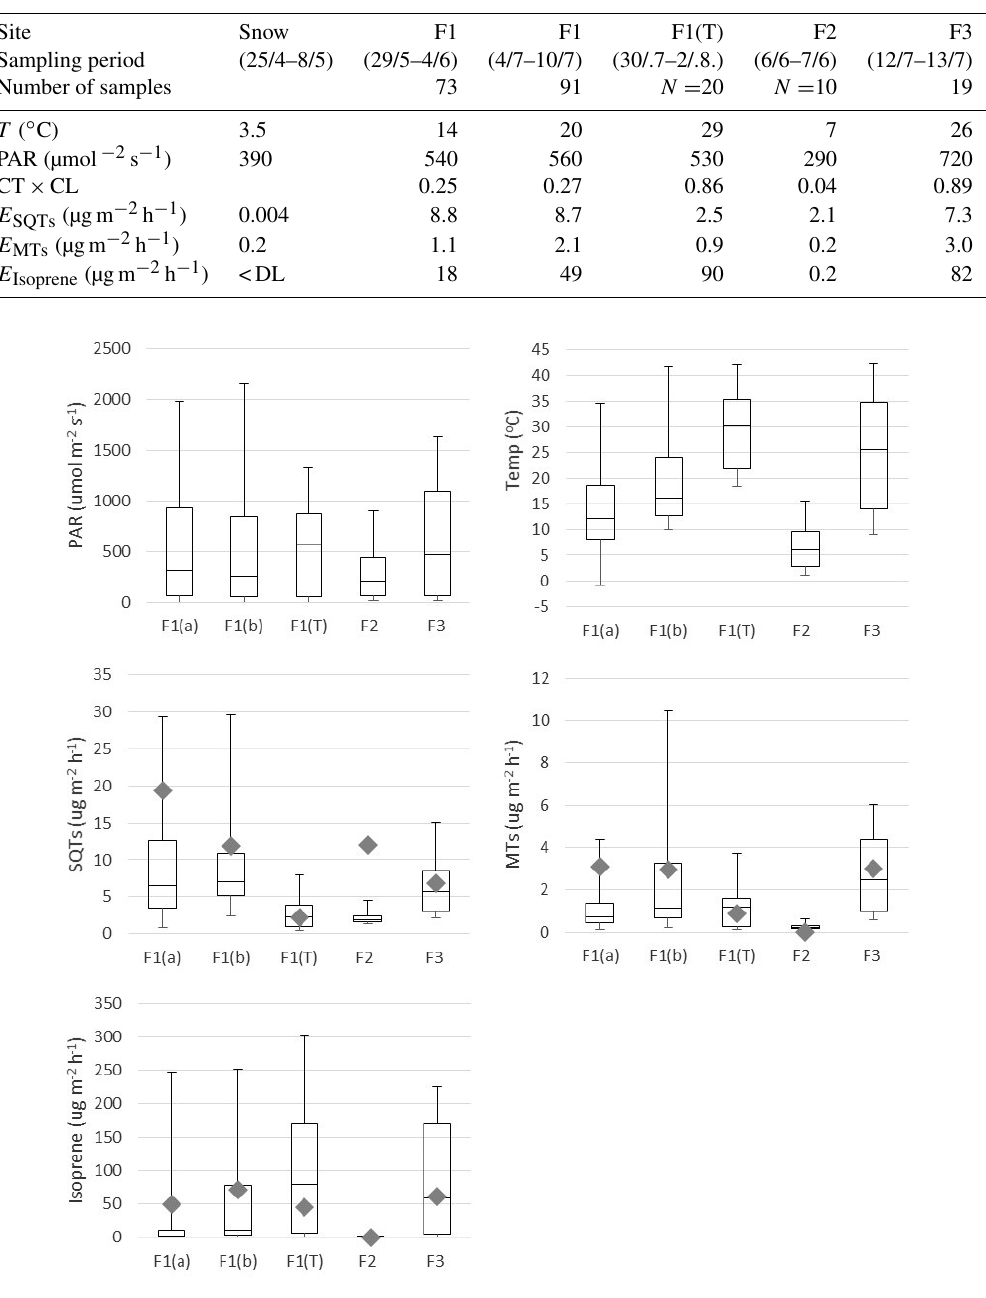
Figure 2. Mean box-and-whisker plots of photosynthetically active radiation (PAR), temperature (Temp), and emission rates of sesquiter- penes (SQTs), monoterpenes (MTs) and isoprene during the various emission measurement periods. The boxes represent first and third quartiles and the horizontal lines in the boxes the median values. The whiskers show the highest and lowest observations. Grey diamonds represent monthly mean emission potentials ( T = 30 ◦ C) and diamonds emission potential ( T = 30 ◦ C and PAR = 1000µmol − 2 s − 1 ). F1(a): frame 1 in 29 May–4 June; F2: frame 2 in 6–7 June; F1(b): frame 1 in 4–10 July; F3: frame 12–13 July; F1(T): tube samples from frame 1 in 30 July–2